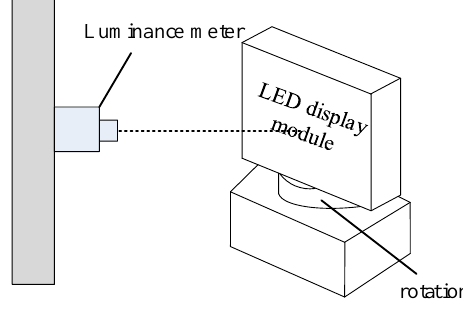
Figure 2. Visual angle measuring equipment.